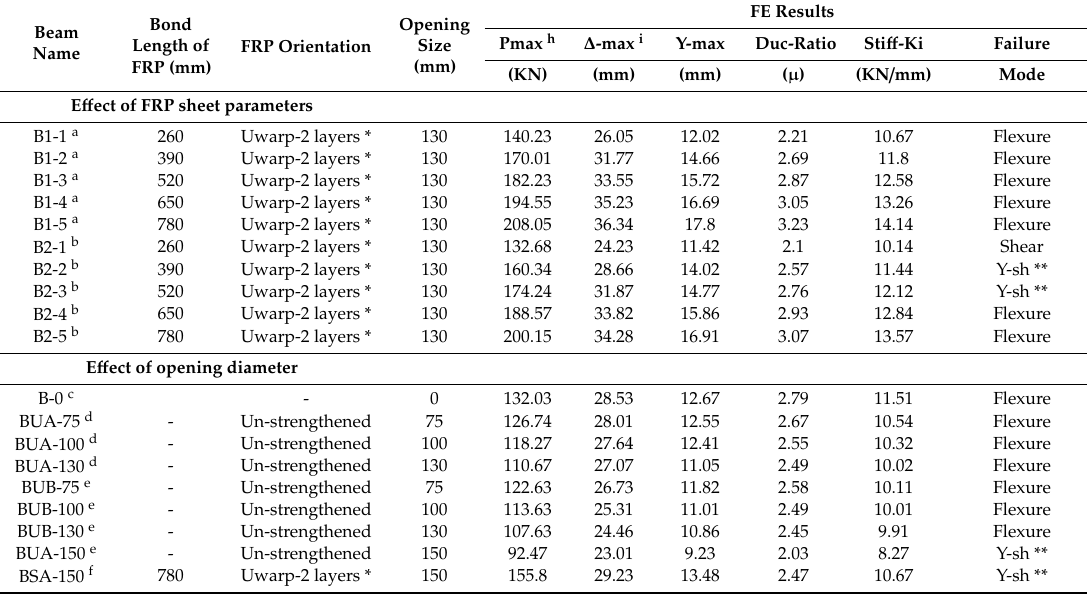
Figure 15. Details of RC beams with openings used in parametric study: ( a ) for group A; ( b ) for group B. Table 6. Details and results of FE models used in the parametric study.